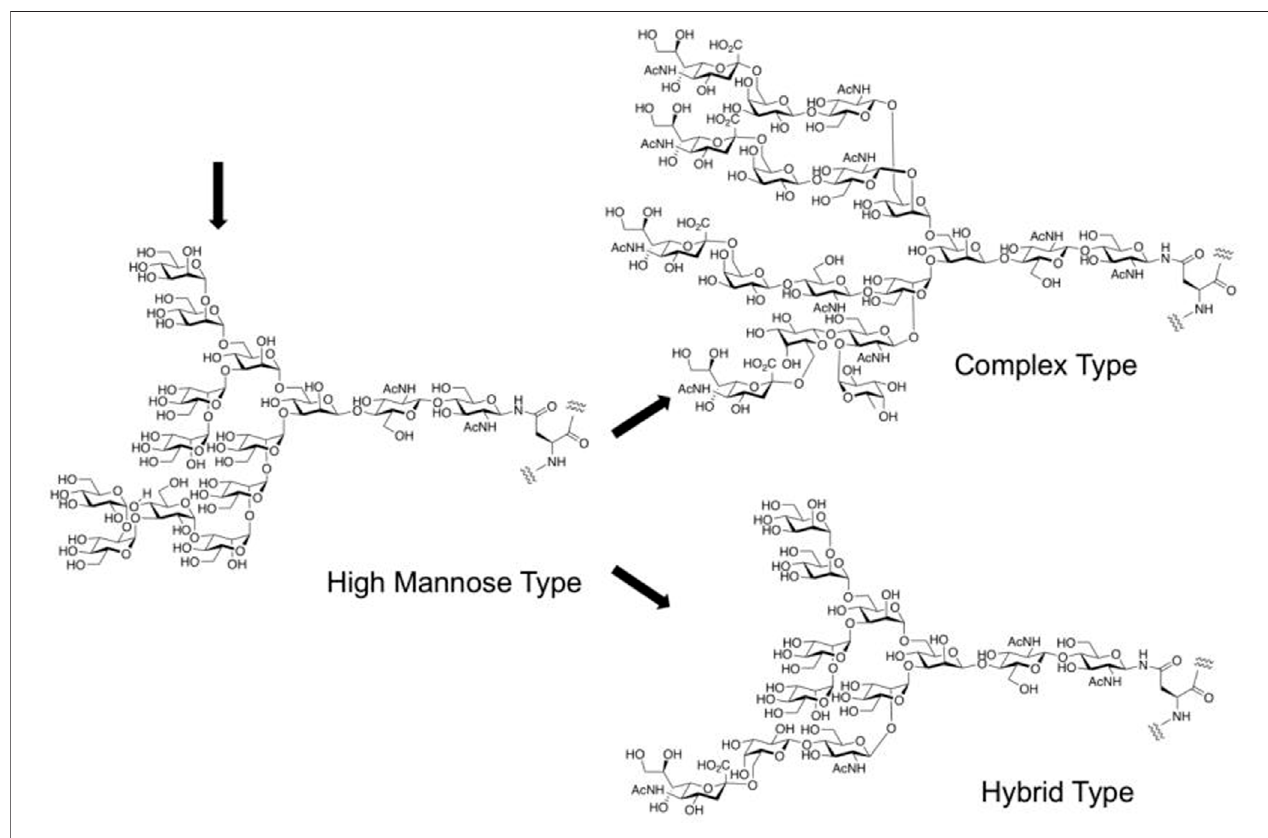
FIGURE 2 | Biosynthesis of N -glycan in a cell expression